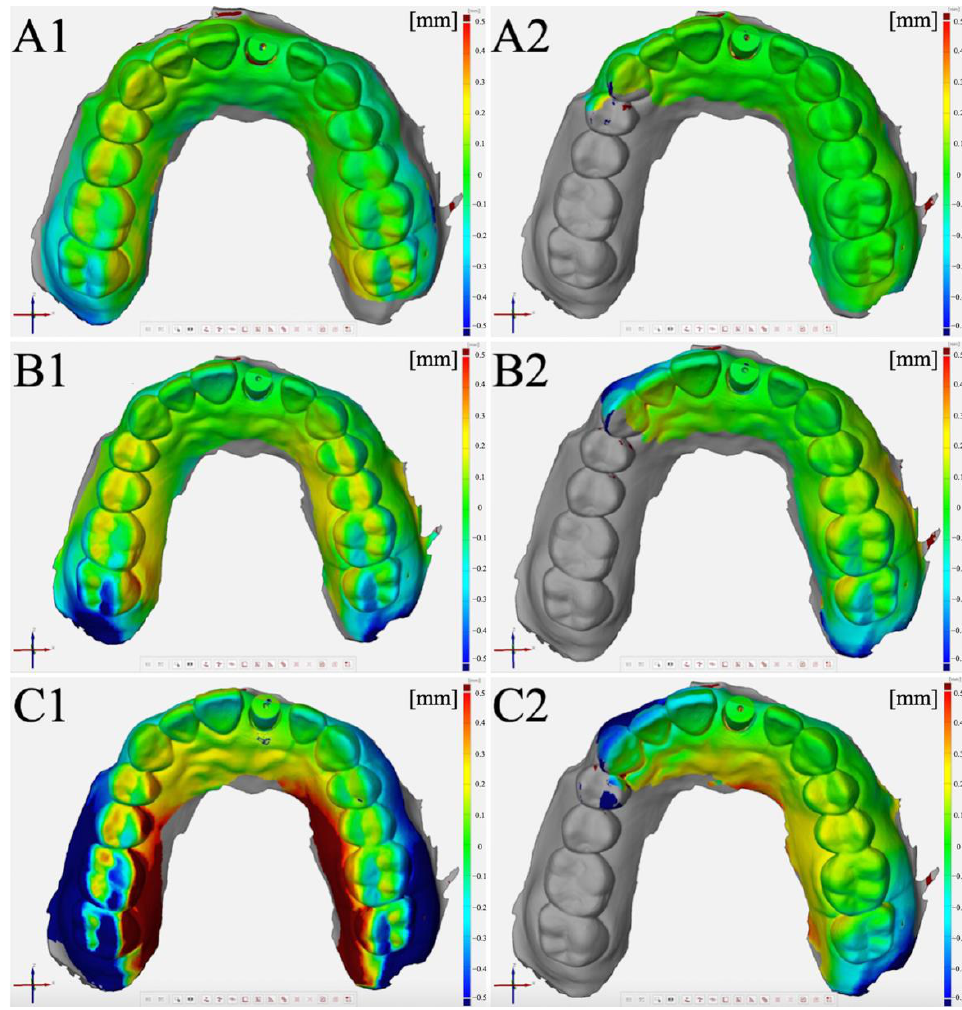
Figure 5. Color maps generated by the superimposition of test scans over reference scan: ( A ) Operator 1. ( B ) Operator 2. ( C ) Operator 3. ( 1 ) Complete-arch scan. ( 2 ) Partial-arch scan.